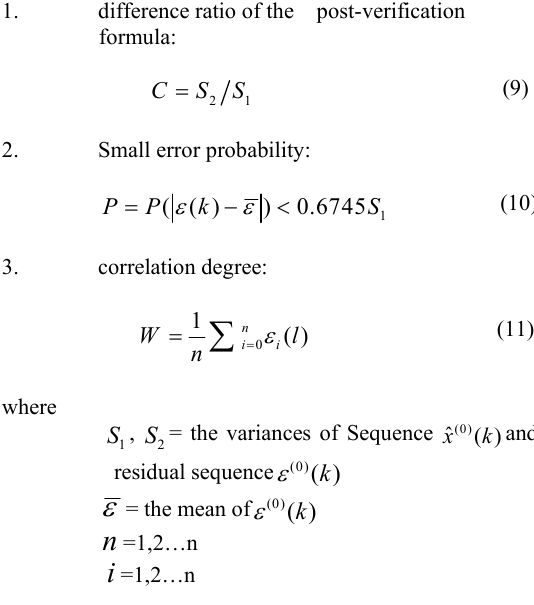
The posterior variance ratio C more smaller, the larger the probability of small error P is. Generally speaking, when C is less than 0.35 and P > 0.95, the higher the prediction accuracy of GM (1,1) and the correlation degree W > 0.6 indicate that the grey model GM (1,1) has higher prediction accuracy.